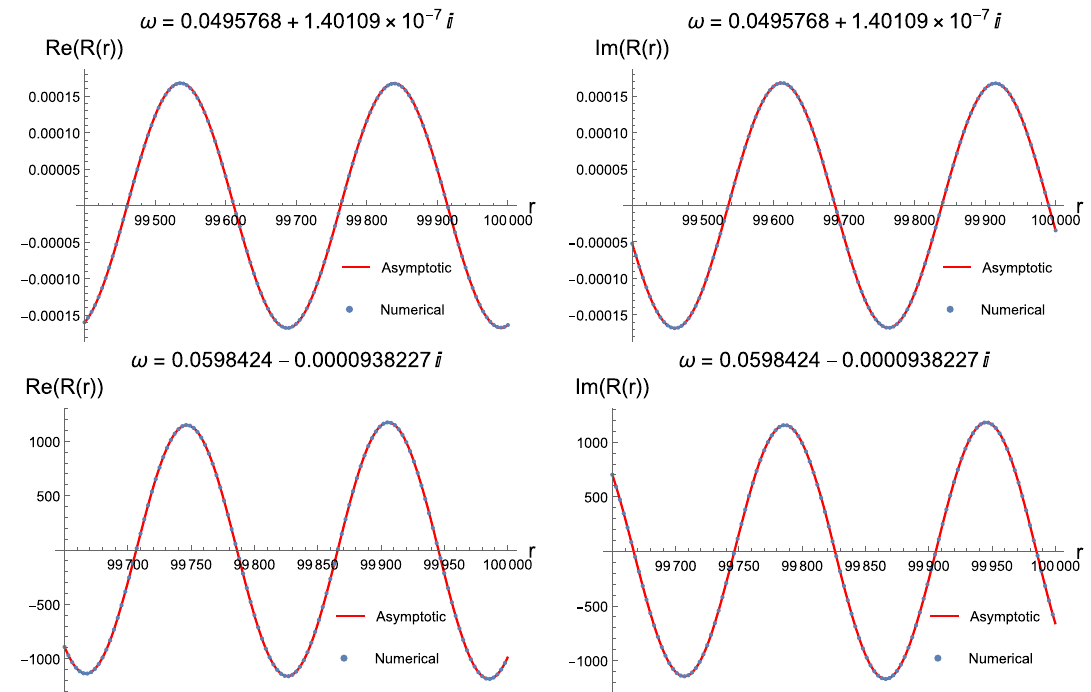
Fig. 3 These plots illustrate how well the numerical data (dots) fit both the real and imaginary parts of the analytical power series expansion of R at large r , for both the stable and unstable QNMs